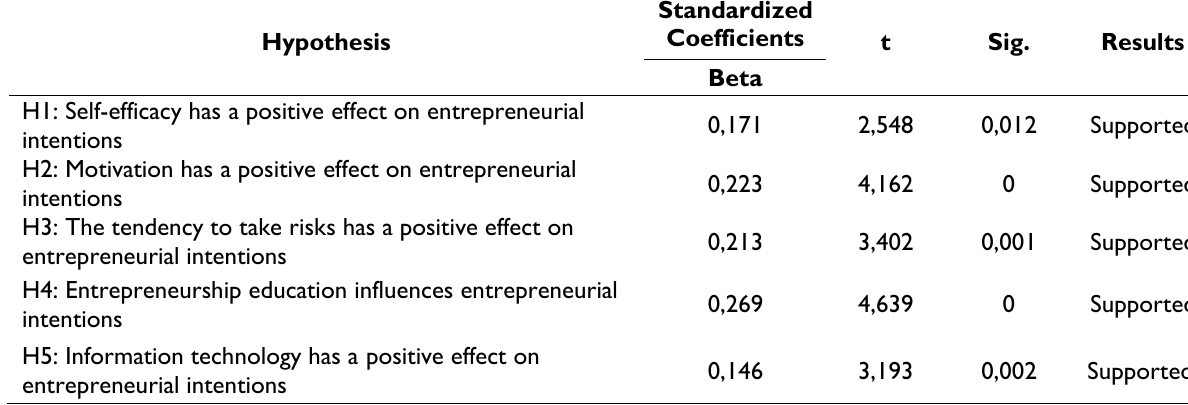
Figure 2. Research Framework with statistical results Table II. Hypothesis Test